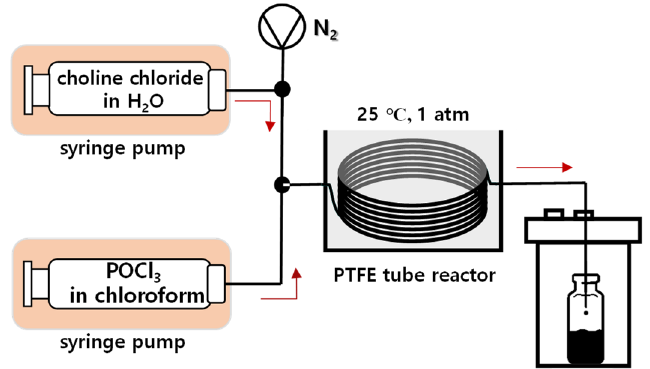
Figure 4. Schematic diagram of flow system for phosphorylcholine ( 3 ) synthesis.